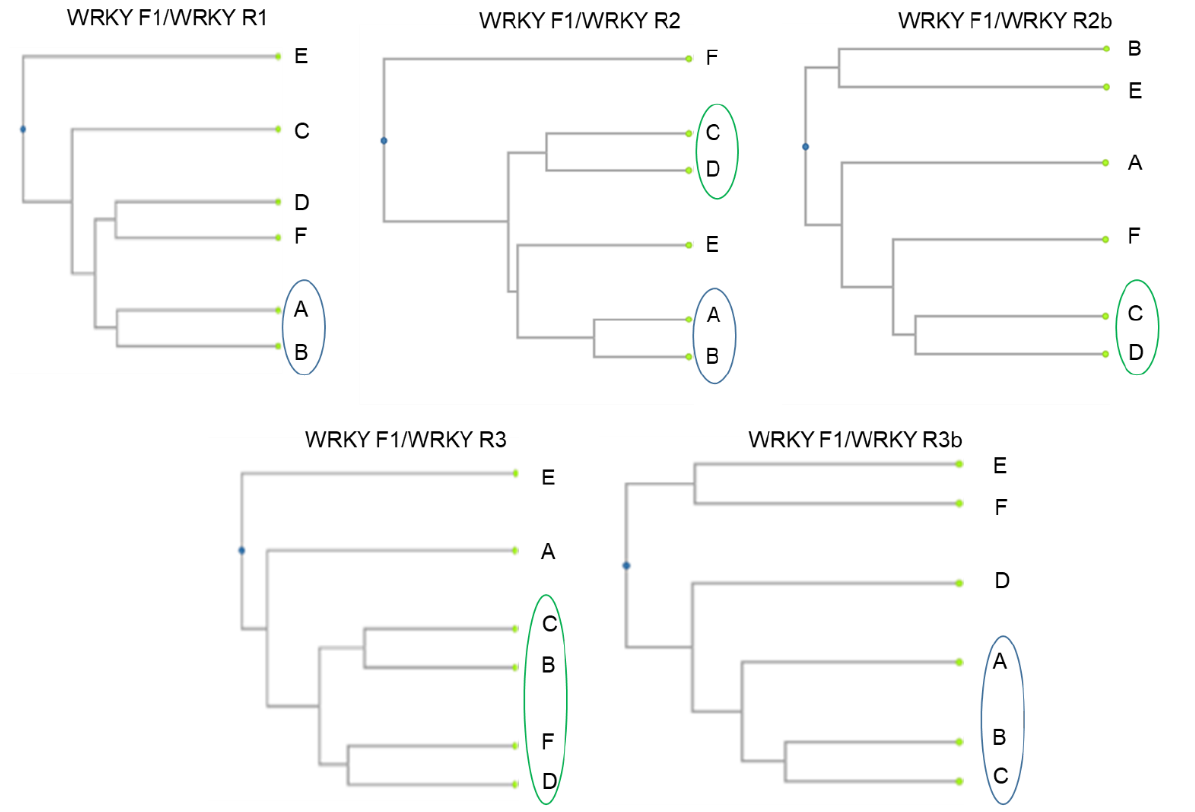
Figure 3. Dendrograms of Jaccard genetic similarity values among analysed Vitis vinifera L. genotypes for CDDP generated fingerprints. A —Grűner Veltliner; B— Weisser Riesling; C — Welschriesling; D — Chardonnay; E — Gewurztraminer; F — Cabernet Sauvignon; WRKY F1, WRKY R1-R3b – types of markers used in the conserved DNA-derived polymorphism [20].